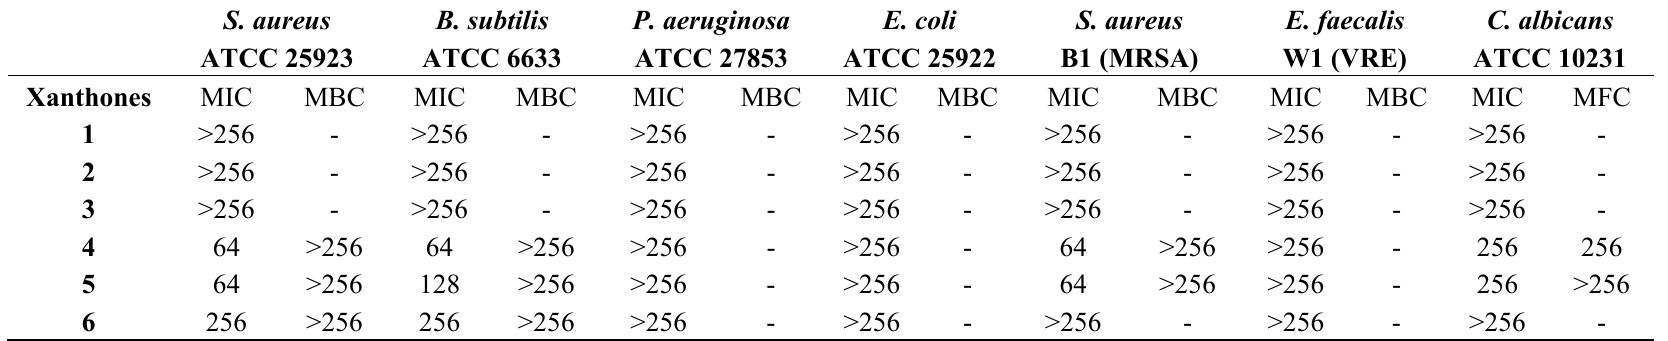
Table 1. Antimicrobial activity (MIC, MBC and MFC) against several bacterial strains (reference and multidrug-resistant strains) and a reference fungal strain ( C. albicans ).